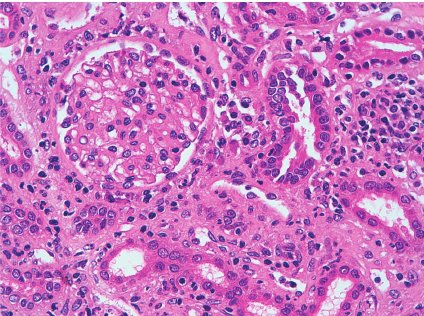
Figure 2: Acute phlogosis inside the tubule. Necrotic debris in the lumen of a tubule. Hematoxylin eosin 630x.